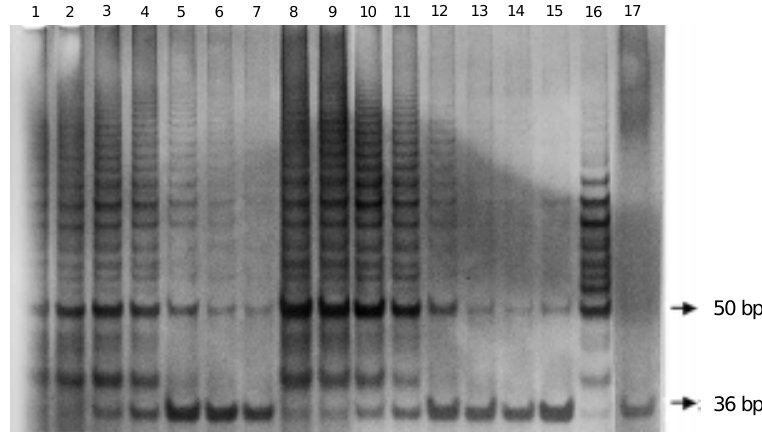
Figure 1. Detection of telomerase activity by the silver-staining method in a papillary thyroid carcinoma cell line (NPA) and in a follicular thyroid carcinoma cell line (ARO). Lanes 1-7 , ARO cell line; lanes 8-14 , NPA. Telomerase activity was detected in extracts from 5,000 cells (lanes 1, 8), 2,500 cells (lanes 2, 9), 1,000 cells (lanes 3, 10), 500 cells (lanes 4, 11), 100 cells (lanes 5, 12), 30 cells (lanes 6, 13), 10 cells (lanes 7, 14), in the primer-dimer control (lane 15) and